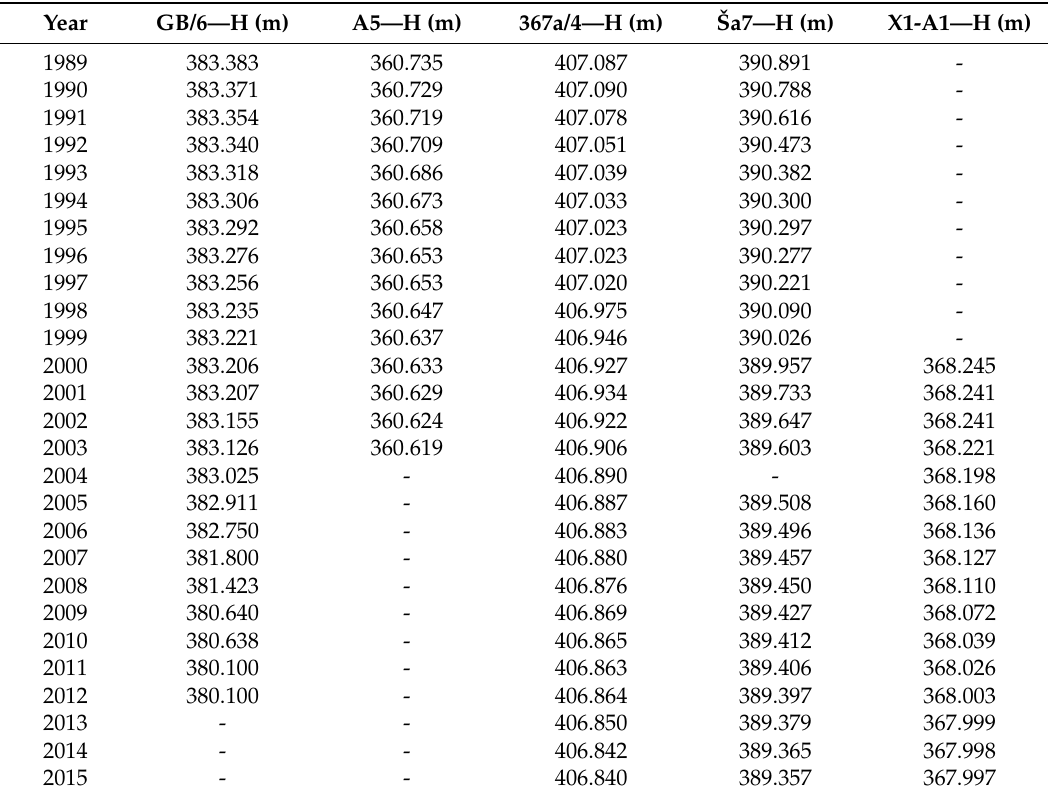
Table 1. Observation point data used in